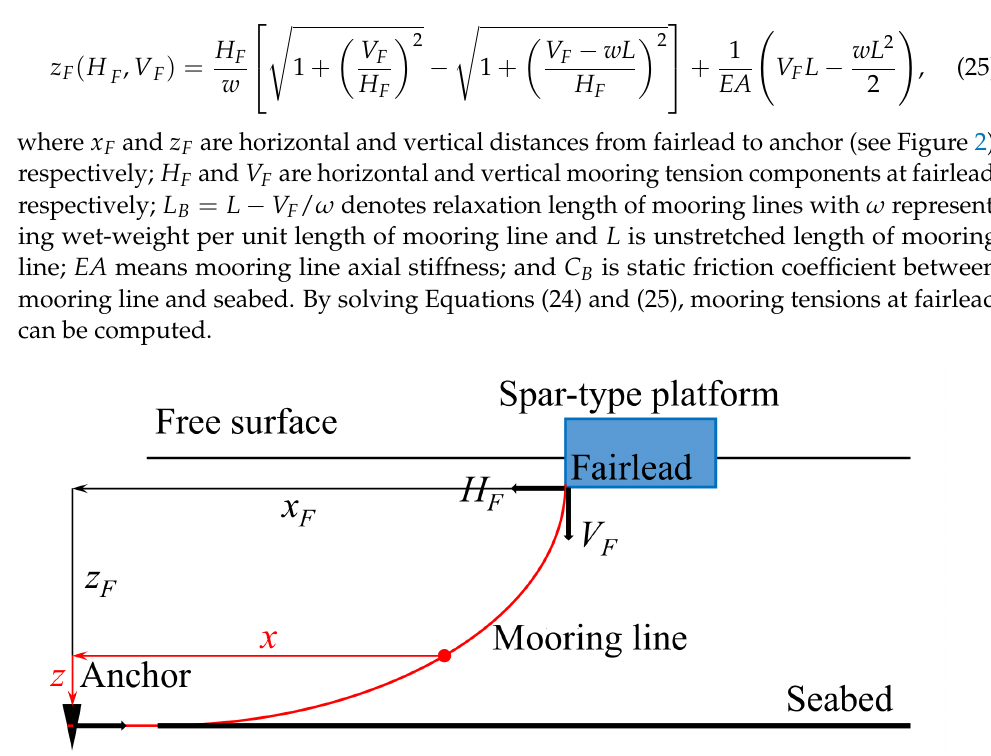
Figure 2. Schematic of mooring system with one mooring